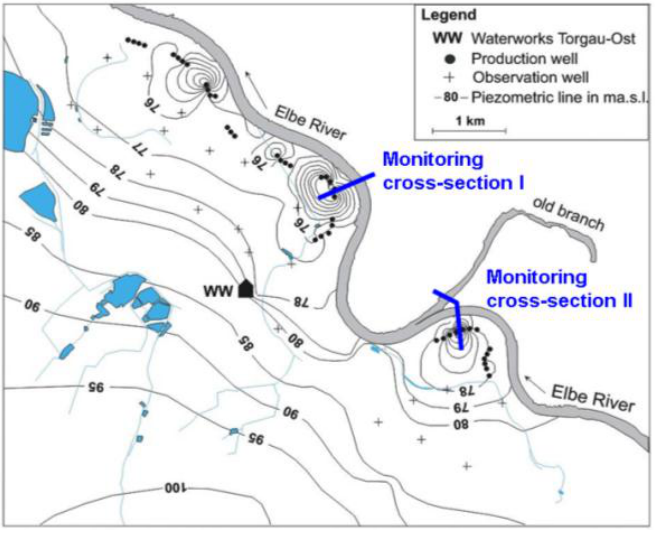
Figure 8. Location map of RBF site Torgau along the River Elbe, showing cross-sections I and II.